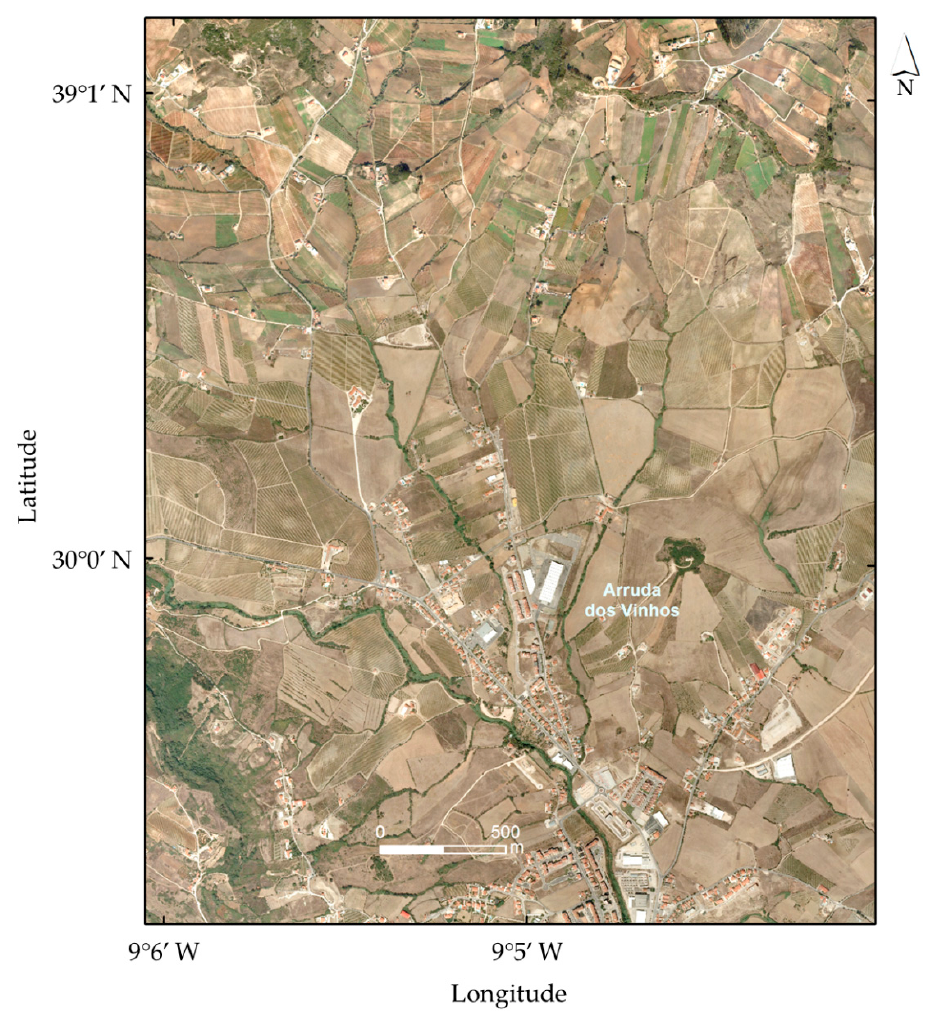
Figure 2. Sample of orthophoto acquired over the study area.